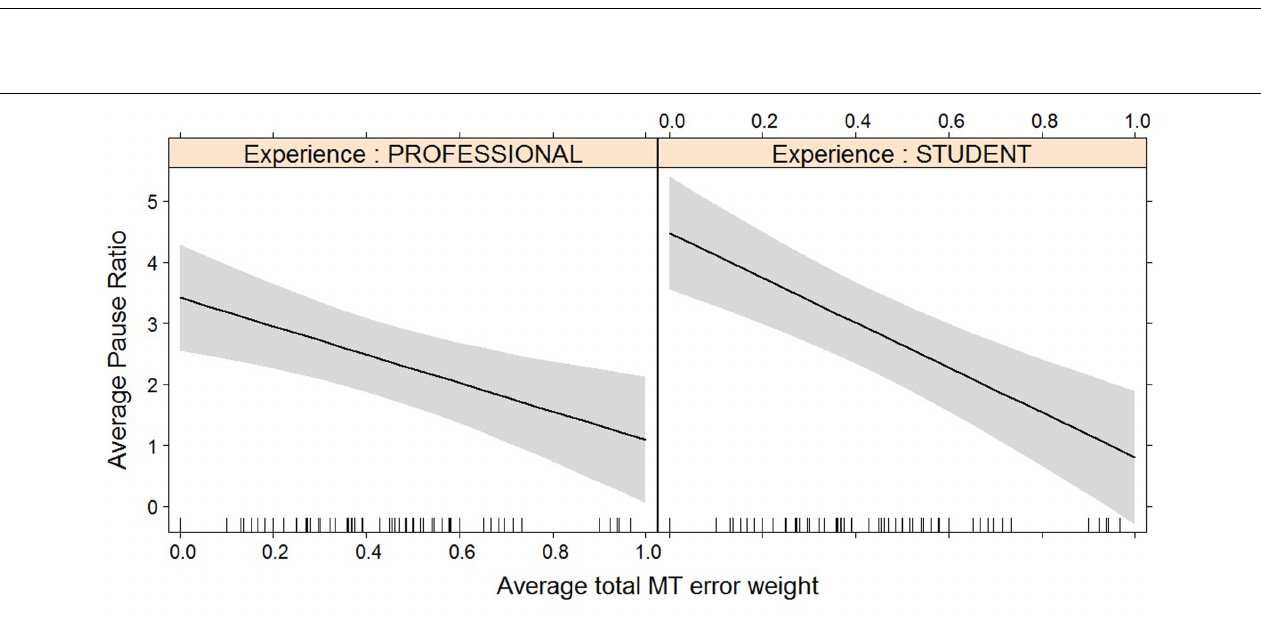
FIGURE 5 | Effect plot of total MT error weight on human-targeted translation error rate (HTER). An increase in average total MT error weight leads to an increase in HTER score, for professionals and students alike.